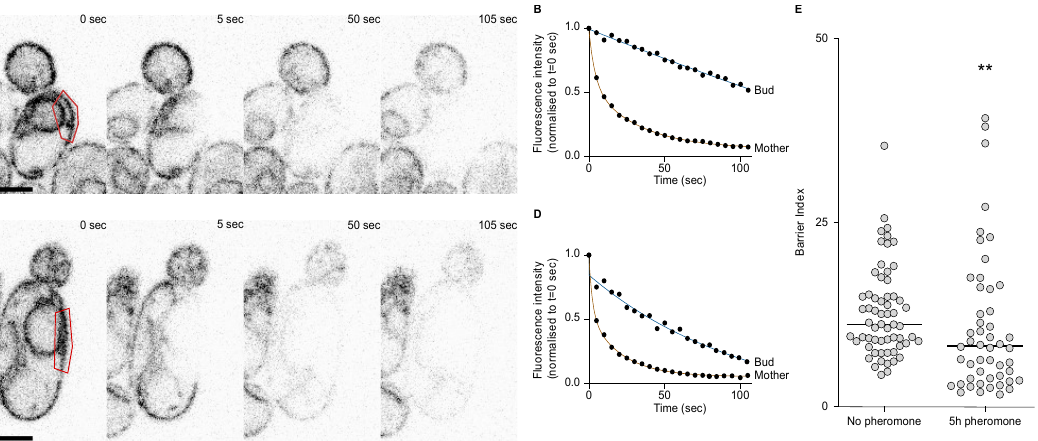
Figure 5. The ER diffusion barrier is weakened during the 1st division after escape. ( A ) FLIP of Sec61-GFP in an untreated wild-type cell. Bleaching area in red. Scale bar = 5 µm. ( B ) Fluorescence decay over time in the mother and bud parts of the cell in ( A ). ( C ) FLIP of Sec61-GFP in a wild-type cell treated with the pheromone for 5 h. Scale bar = 5 µm. ( D ) Fluorescence decay over time in the mother and bud parts of the cell in ( C ). ( E ) Barrier indices for cells untreated (n = 61 cells) or treated with the pheromone for 5 hours (n = 50 cells). The ** p value = 0.0015 obtained from a Mann–Whitney test.